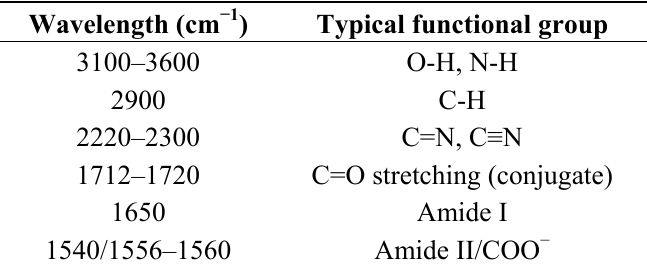
Table 2. Assignment of the principal IR absorption bond [4,19,30–32].